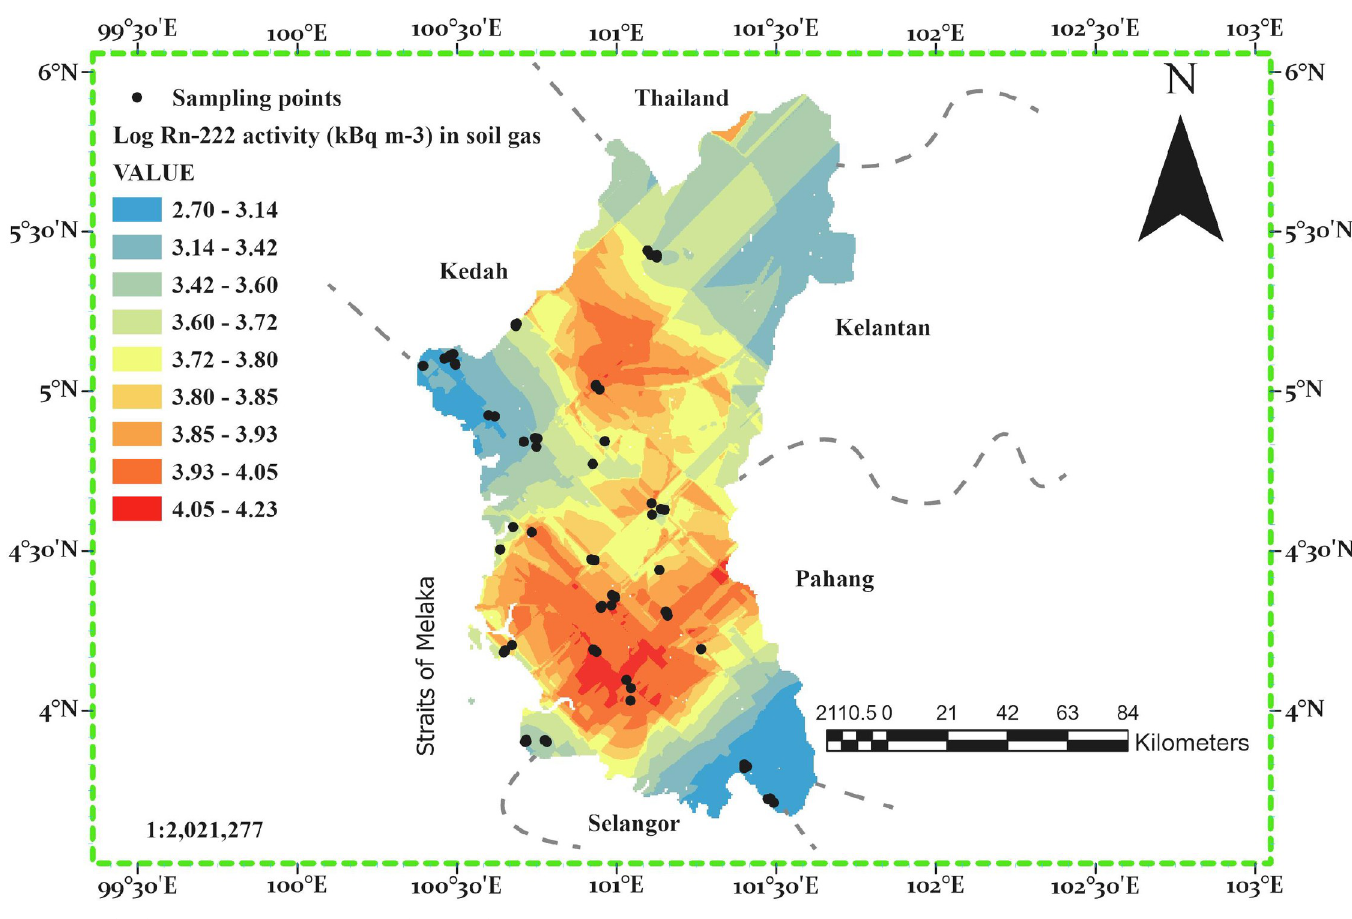
Fig 3. Map of radon activity concentration in soil gas Perak